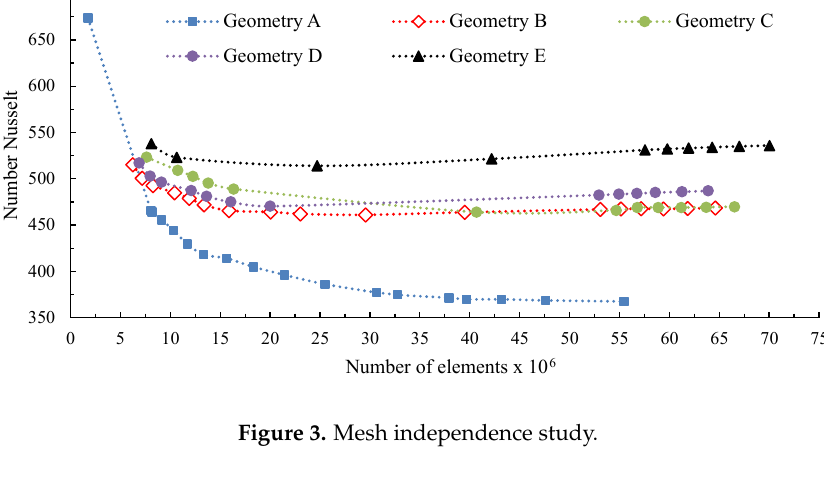
Figure 3. Mesh independence study.